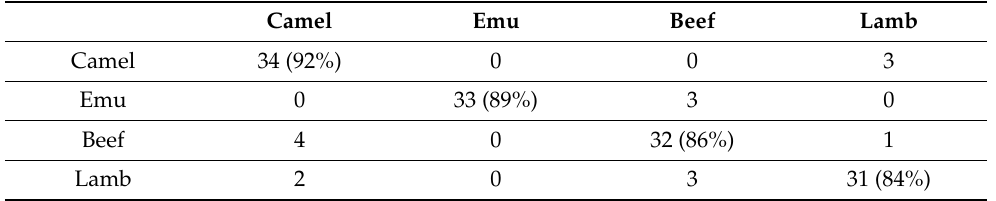
Table 1. Linear discriminant analysis confusion matrix of meat samples analyzed using near infrared reflectance spectroscopy. In brackets are the percentages of correct classification.